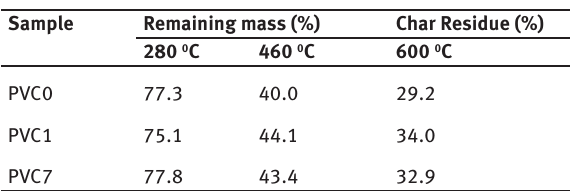
Table 2: Thermal Gravimetric Analysis results of PVC samples.